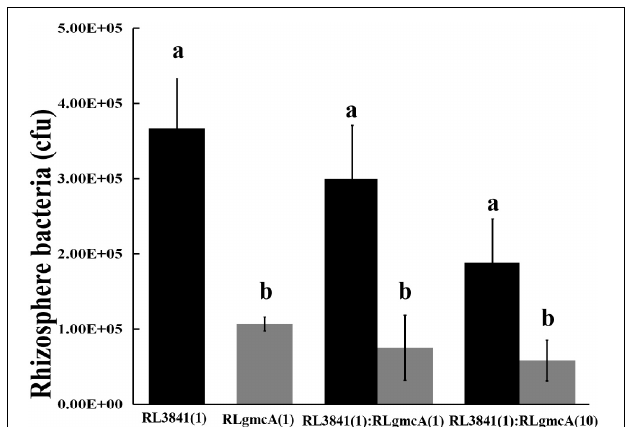
FIGURE 1 | Competition of the wild type (RL3841) (black bars) and the gmcA mutant (RLgmcA) (gray bars) in sterile rhizospheres. Inoculation ratios are given on the x- axis, with 1 corresponding to 1,000 CFU. Number of bacteria (per plant) recovered from 10 plants (mean ± SEM) are shown. a , b Different letters indicate the value is significantly different between mutant RLgmcA and wild-type RL3841 control (one-way ANOVA, P < 0.05).